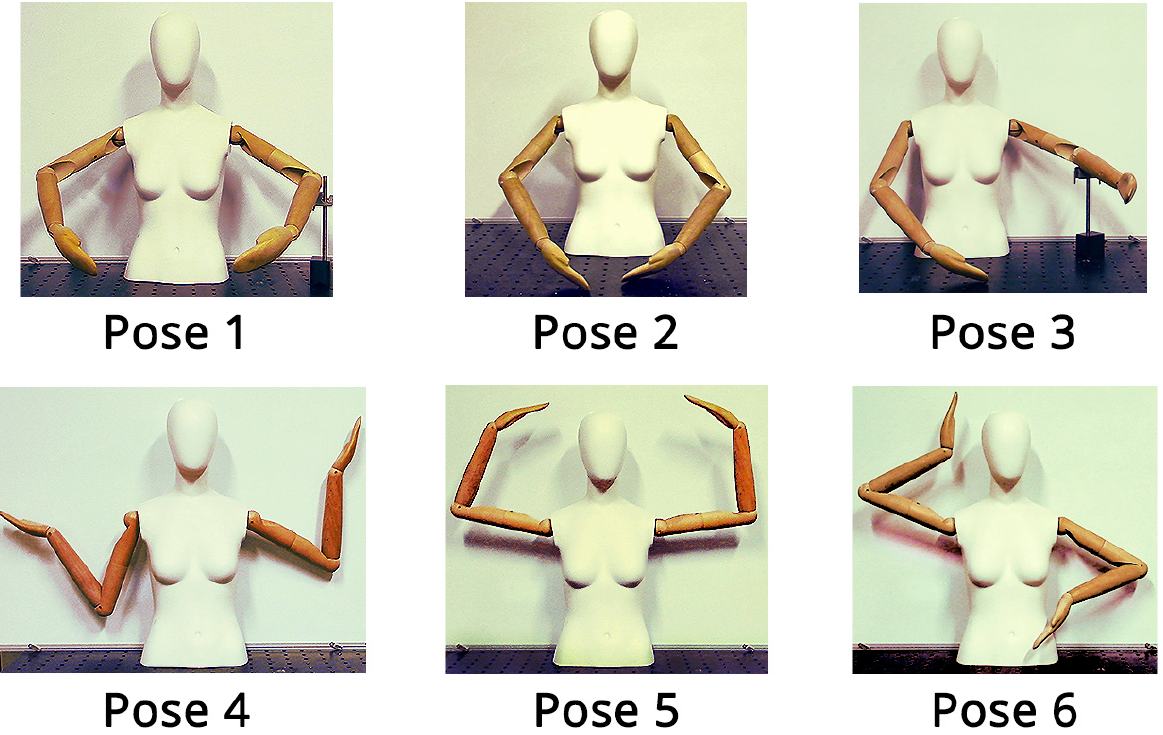
Figure 9. Dummy poses considered for the analysis as in [43].